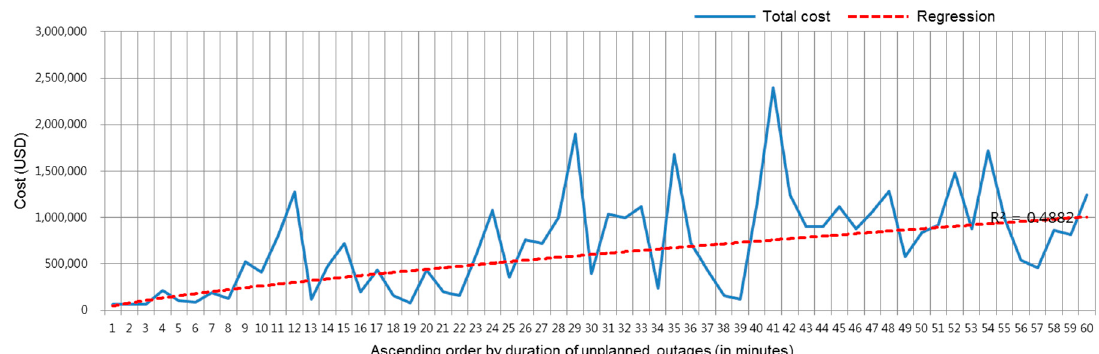
Figure 3. Relationship between cost and duration of unplanned outages [18].